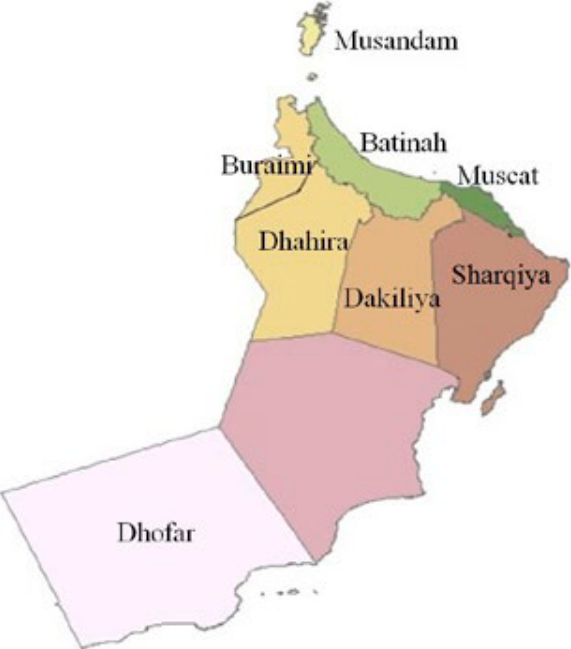
Figure 1. Map of Oman showing the eight regions which were covered during a survey of occurrence of witches’ broom in acid lime